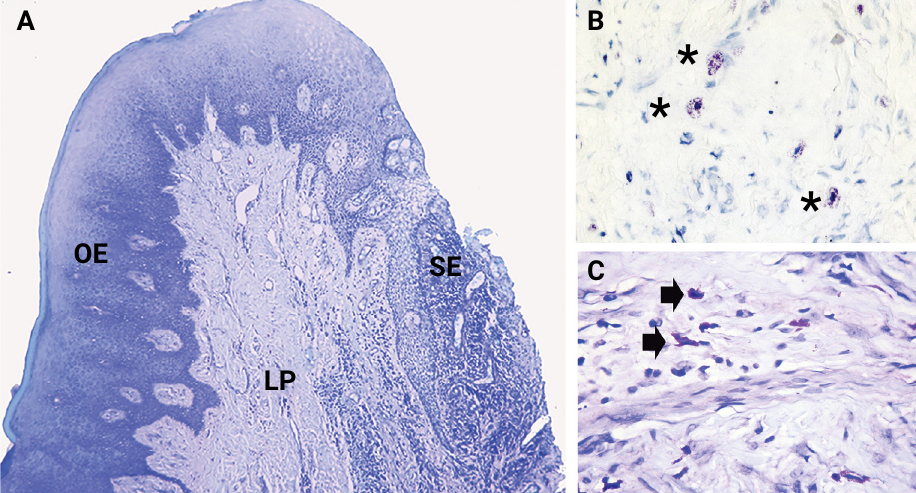
Figure 2. Gingival sample stained with o-toluidine blue. A) The oral (OE) and sulcular (SE) epithelium and lamina propria (LP) in gingival tissue sample were showed in toluidine blue stain (o-toluidine blue, original magnification 50x). B) Degranulated mast cells - it is observed less intense metachromasia and obvious clear outline of the nucleus (asterisk) (o-toluidine blue, 400x original magnification). C) Intacted mast cells- it is observed intense and dense metachromasia and nucleus not apparent (arrow) (o-toluidine blue, 400x original